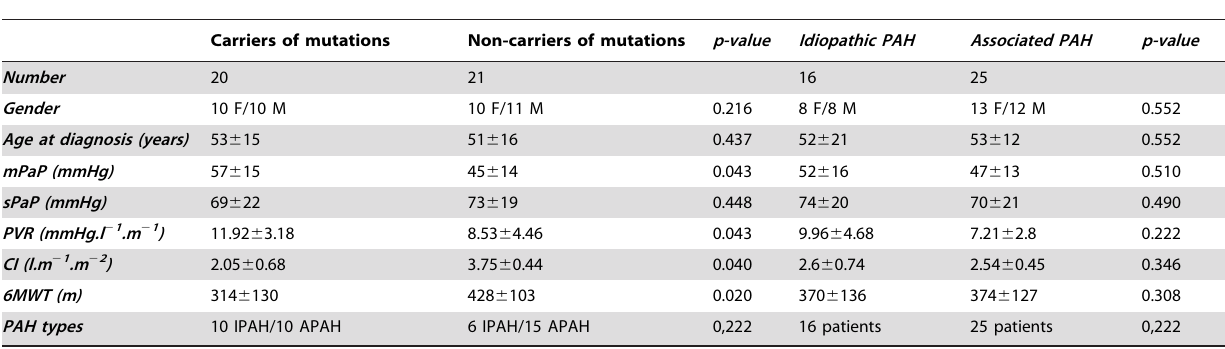
Table 1. Clinical features and hemodynamic parameters of patients.